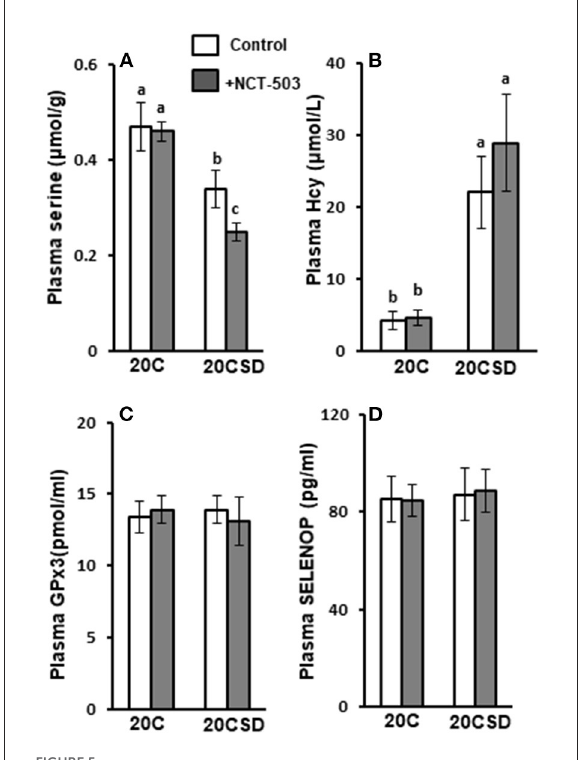
FIGURE5 Effects of PHGDH inhibitor and serine deficiency on plasma concentrations of serine (A) , Hcy (B) , GPx3 (C) and SELENOP (D) in pregnant rats fed 20% casein (experiment 2). Each value is the mean ± SEM, n = 10. Means in a panel without a common letter differ, P < 0.05. See the legend of Figure 2 for other abbreviations. PHGDH, 3-phosphoglycerate